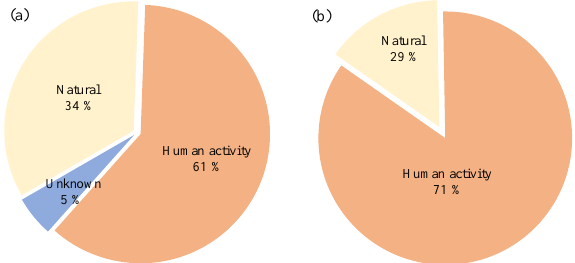
Figure 11. Role of engineering activities in loess failures: (a) Shanxi Province; and (b) Huangling County, Shaanxi